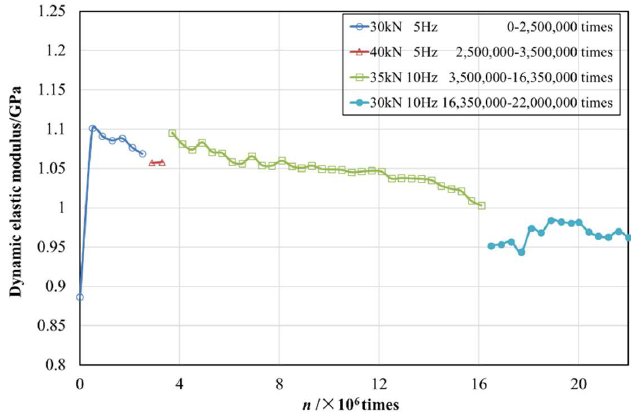
Figure 8. Dynamic elastic modulus–cyclic number ( n ) curve of structural EPS concrete.